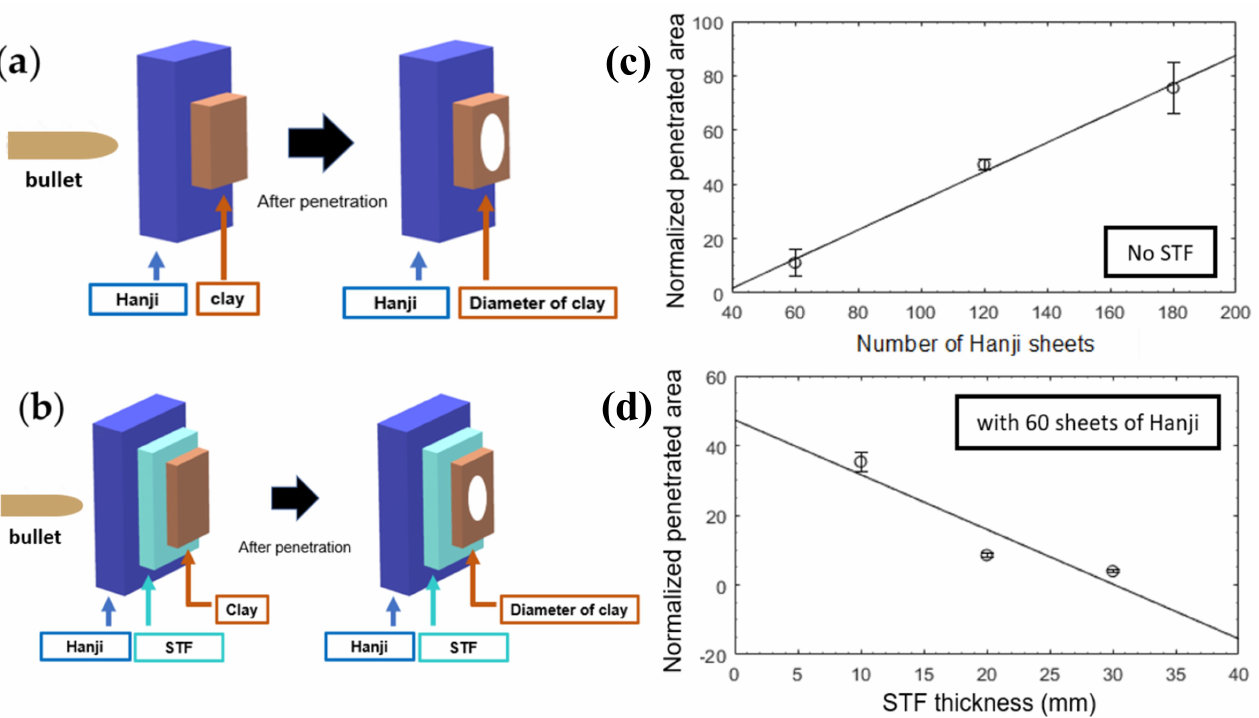
Figure 12. Schematics illustrating the position of the panels used in the ballistic test: ( a ) composites with only Hanji paper layers; ( b ) hybrid composites composed of Hanji and cornstarch STF; ( c ) graph of the normalized penetrated area in the panels as a function of the number of Hanji paper layers; ( d ) graph of the normalized penetrated area in the panels as a function of the STF thickness. Adapted with permission from Ref. [170]. Copyright 2020, MDPI